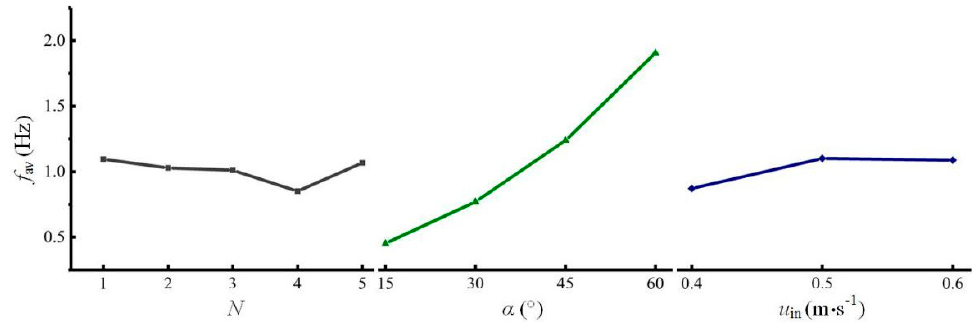
Figure 5. Relationships between the average L/D cycle frequency and three factors (single-sided illumination).